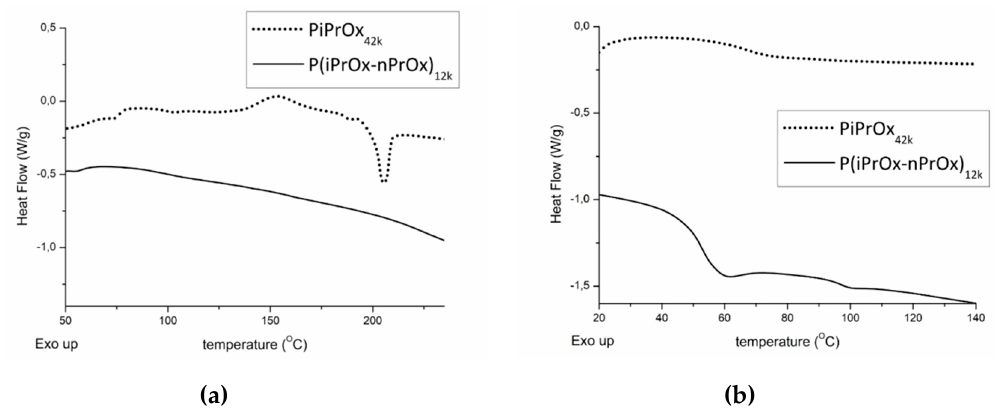
Figure 1. Differential scanning calorimetry (DSC) traces of PiPrOx 42k and P(iPrOx–nPrOx) 12k . ( a ) First run and ( b ) second run after quenching from melt (220 °C) in liquid nitrogen. Heating rate of 10 °C/min.